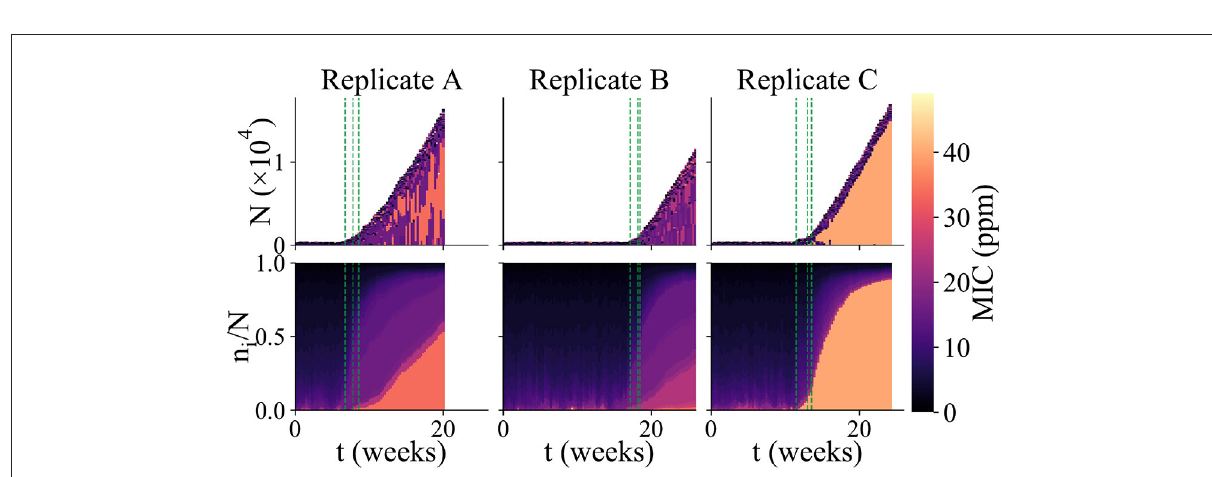
FIGURE4 Variability among replicate simulation runs. Community composition of 3 replicate simulations runs in which biofilm formed (each column shows an independent simulation run). The upper panels show total community size and composition (as in Figure 2a), while the lower panels show the relative abundance of microbes with different MIC values (as in Figure 2c). The color scale indicates MIC value. As in Figure 2, the green dashed lines indicate the times at which new microhabitats are added (for the first 3 microhabitats only). Replicate A shows an example of a run which reached the “thickness limit” and stopped